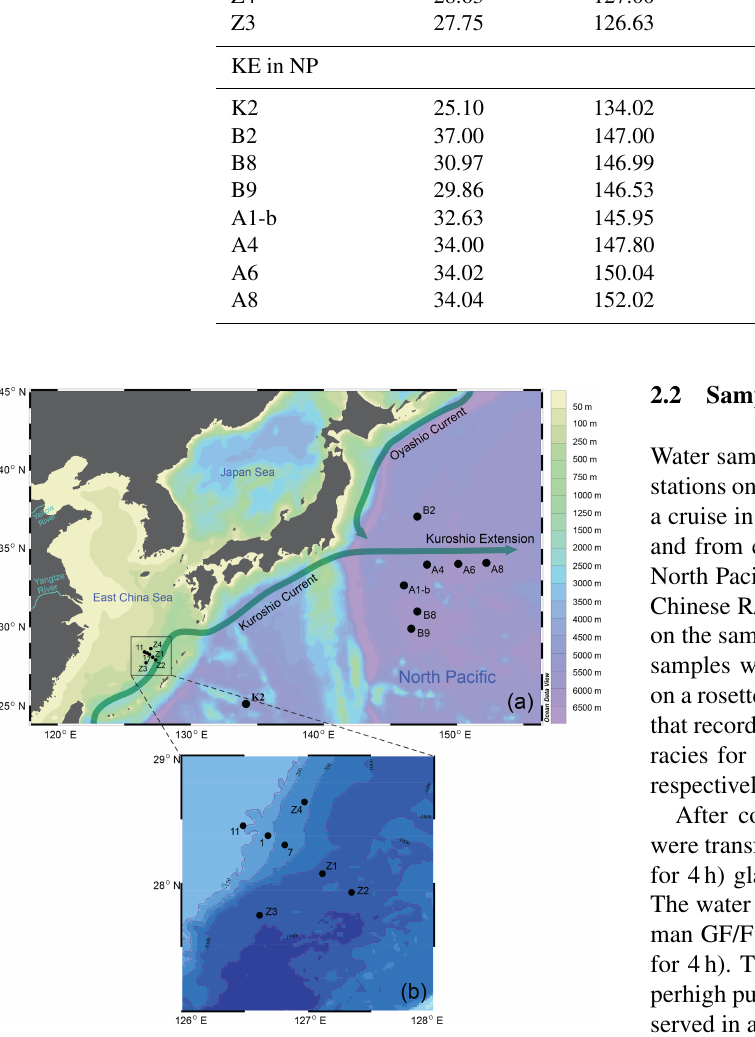
Figure 1. Map showing the study region and the sampling stations in the ECS and the northwestern North Pacific during two cruises in 2014–2015 described in the text. Two major western boundary cur- rents, the northeastward-flowing Kuroshio and southward-flowing Oyashio, meet and form the Kuroshio Extension flowing eastward to the north central